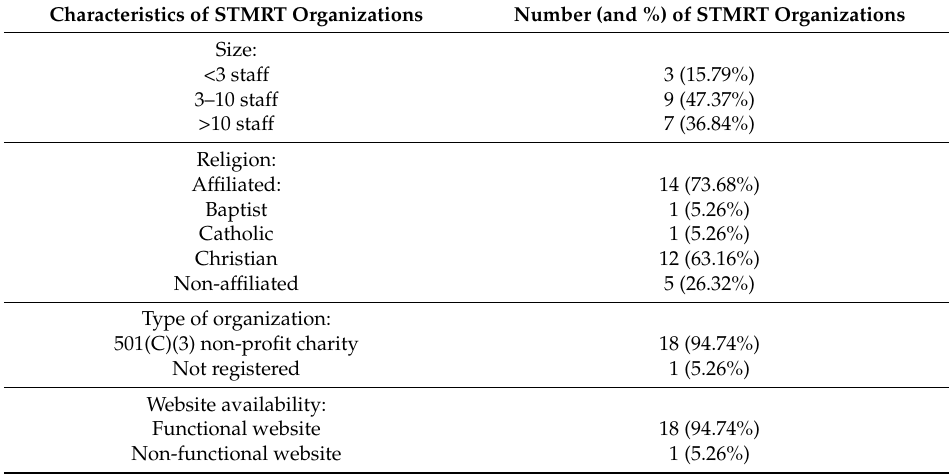
Table 1. Key characteristics of sampled short-term medical relief (STMRT) organizations. Characteristics of STMRT